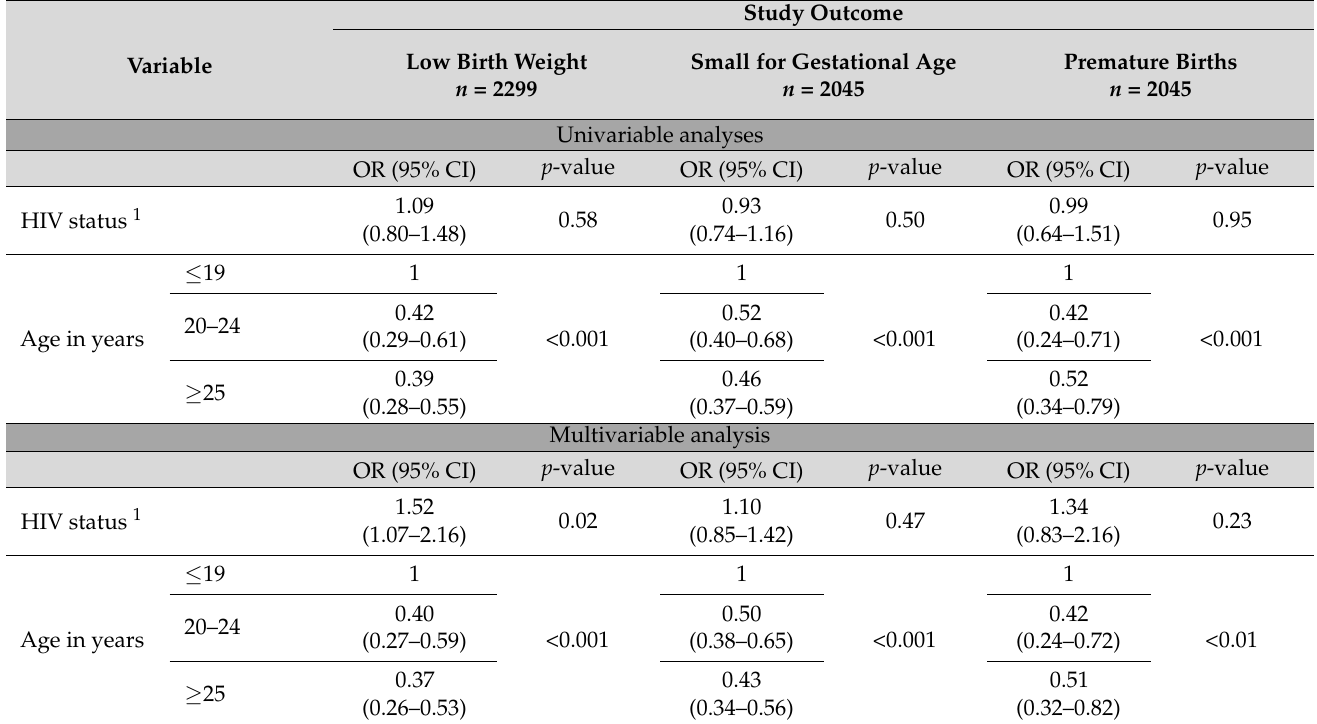
Table 4. Univariable and multivariable analyses: adverse perinatal outcomes.